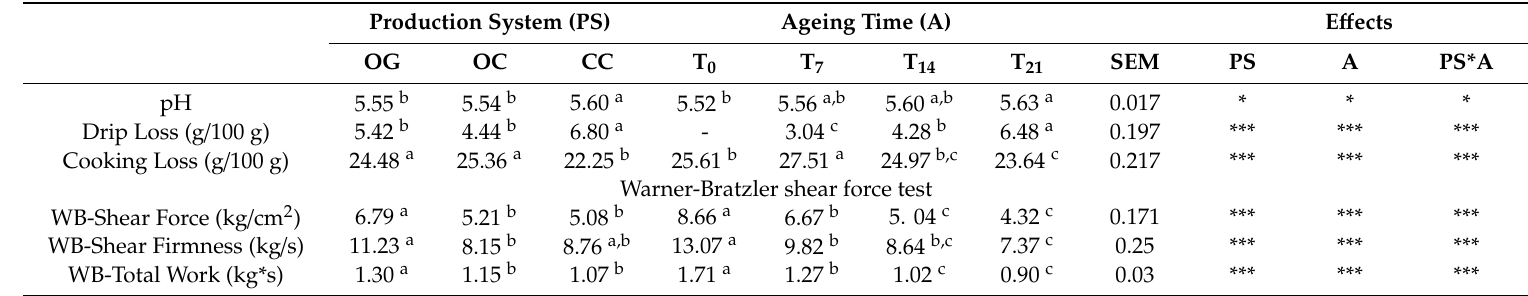
Table 1. E ff ect of the production systems (organic grazing, OG; organic concentrate, OC; and conventional concentrate, CC) and ageing time (T 0 , T 7 , T 14 , T 21 : 0, 7, 14, and 21 days, respectively) on pH, water-holding capacity, and textural instrumental parameters of Longissimus thoracis from calves of the Retinta